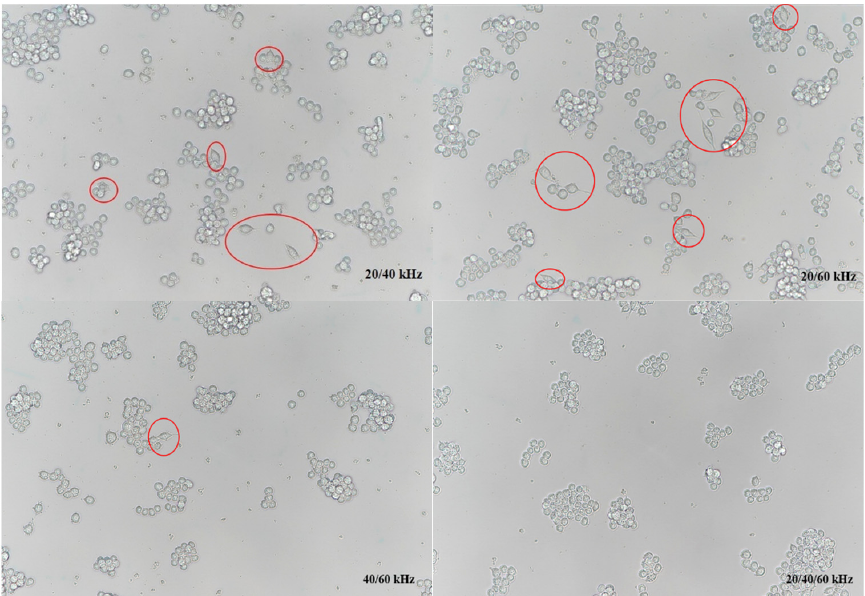
Figure 6. The effect of lentinan on the morphological features of RAW264.7 macrophages.